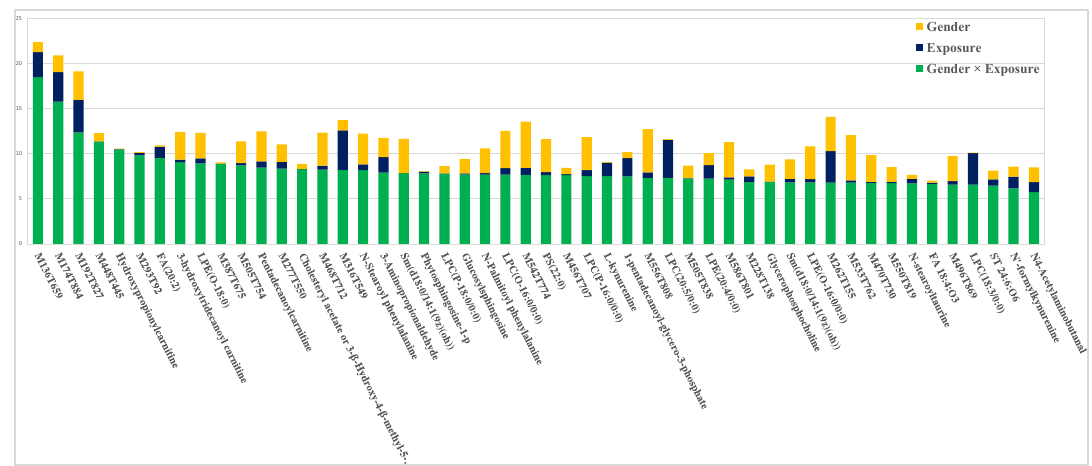
Figure 3. E ff ect-specific variable importance in the projection (VIP 2 ) values for the 50 highest ranked metabolites according to the impact of the interaction Gender × Exposure